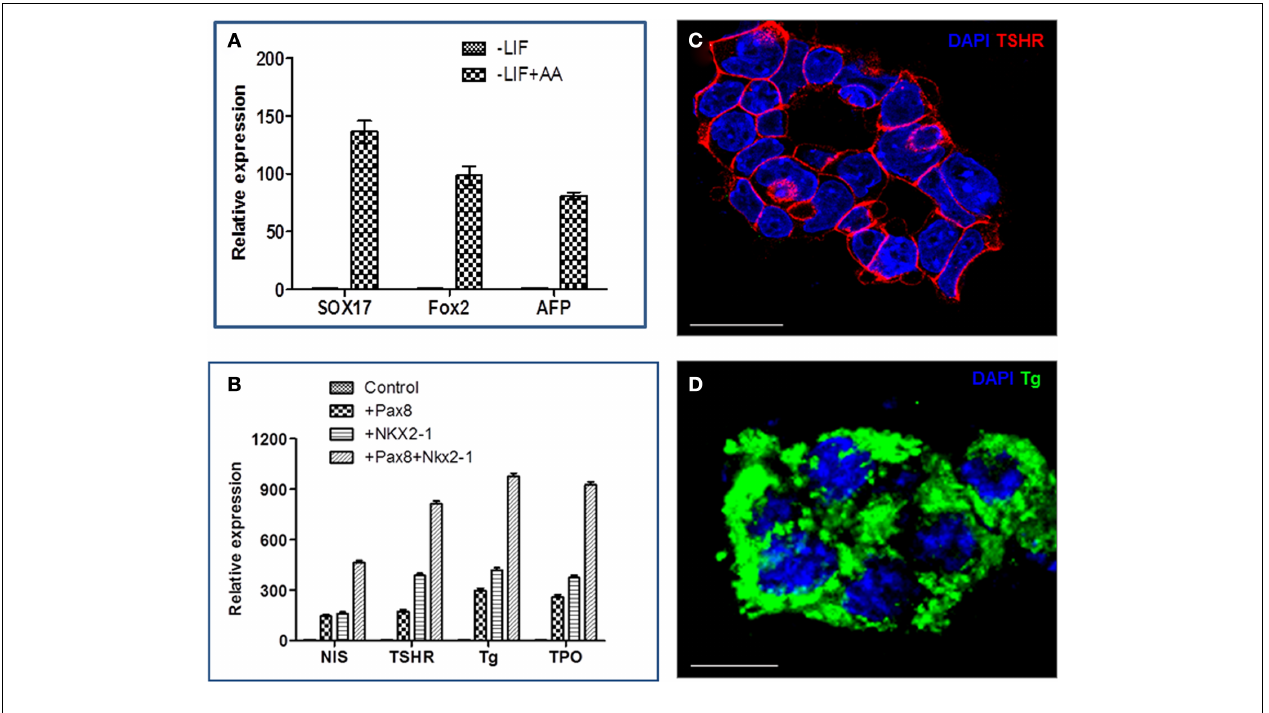
FIGURE 3 | The differentiation of iPS cells into thyroid cells . (A) Representative RT-PCR analysis for the expression of endoderm markers, Sox17, Fox2, and AFP, in Activin A (AA) treated and untreated cells. Data were expressed as mean (cid:6) SEM and represent one of three separate experiments. (B) Thyroid-specific genes (Tg, TPO, TSHR, and NIS) in individual cell lines after differentiation with Activin A and TSH. Data were expressed as mean (cid:6) SEM and represent one of three separate